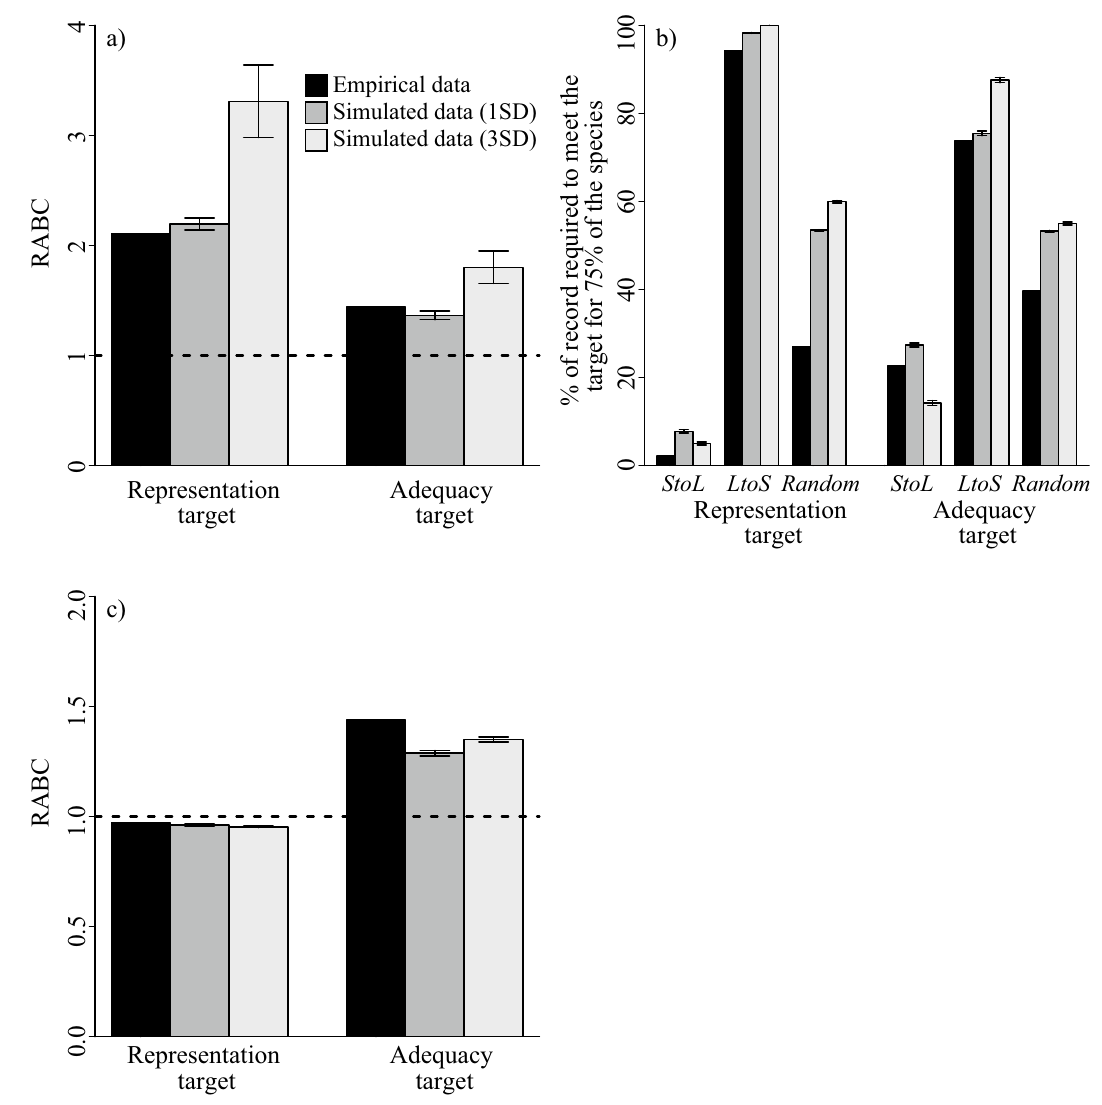
Figure 2. The performance of StoL over LtoS on randomly generated taxon distributions in a 68 × 68 square space. Performance was evaluated by ( a ) the number of taxa meeting the target, ( b ) the percentage of records required to meet the conservation target of 75% of the taxa being protected, and ( c ) the total cost of selected grid